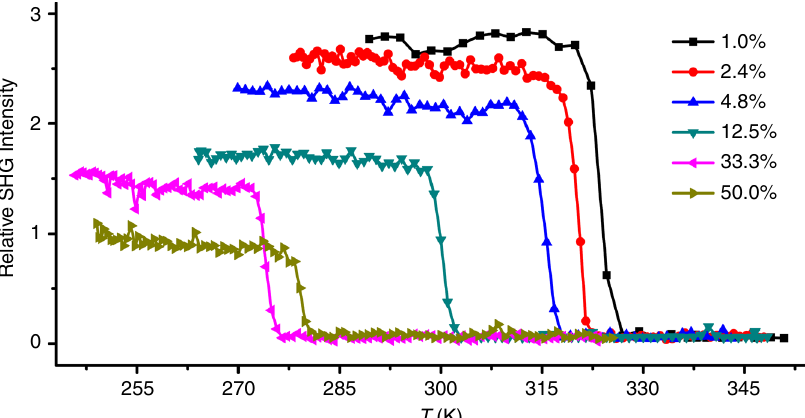
Fig. 9 Variable-temperature SHG intensity of CP solid solutions {1 1-x 2 x }. The measurements were performed on their polycrystalline samples upon a heating process. The mixing ratio ( x ) of CP 2 ranges from 1.0 to